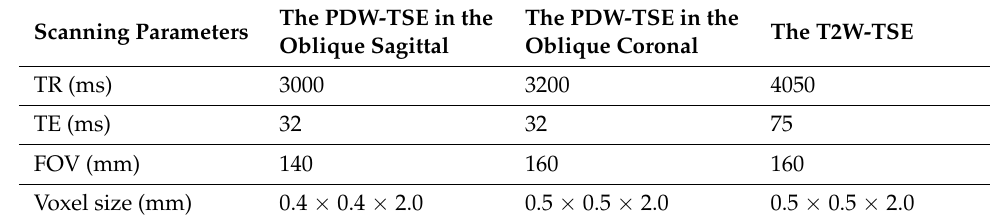
Table 1. All scanning parameters of MRI. Scanning